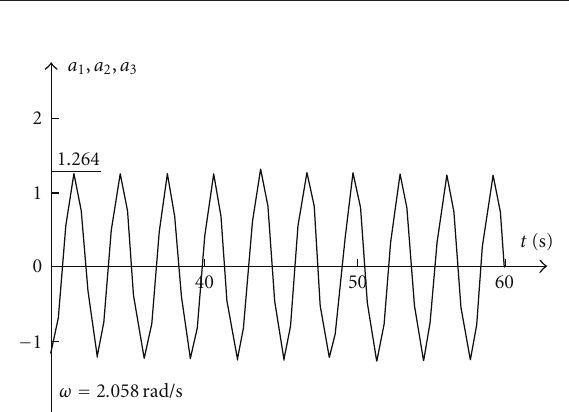
Figure 13: Time responses of Example 2.